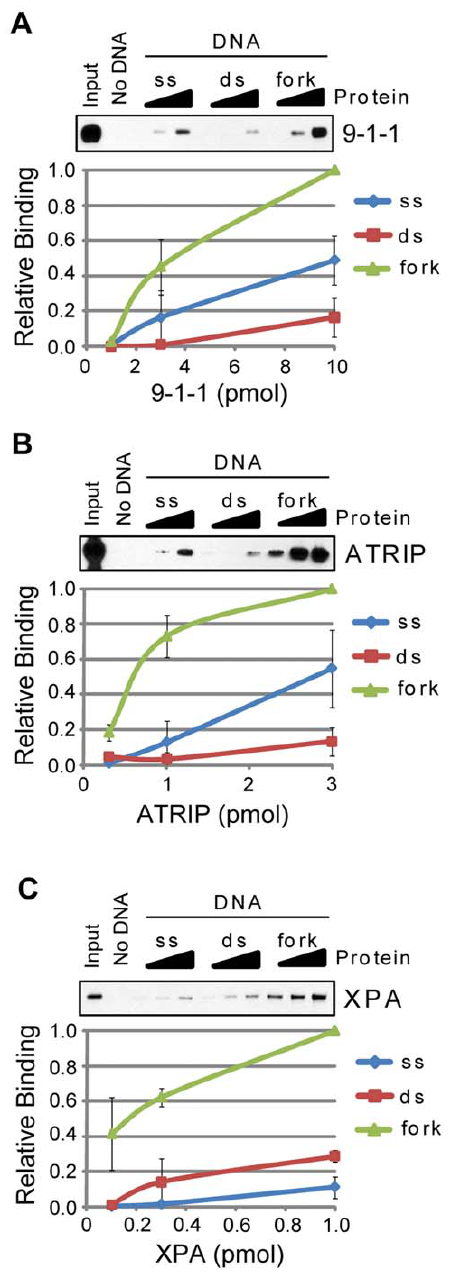
Figure 2. RPA, FAAP24, and Chk1 preferentially bind ssDNA and branched DNA. The association of each of the indicated purified proteins with beads alone (No DNA) or to single-stranded (ss), double- stranded (ds), and branched, replication fork-like (fork) DNA bound to magnetic beads was analyzed by SDS-PAGE and immunoblotting. Each of the following proteins was analyzed for binding to each DNA structure: (A) RPA, (B) FAAP24, and (C) Chk1. Reactions were carried out as described in the Methods section. Experiments were repeated two to four times and the average binding values and standard deviations graphed. Input lane contains the lowest amount of protein used in each binding assay.